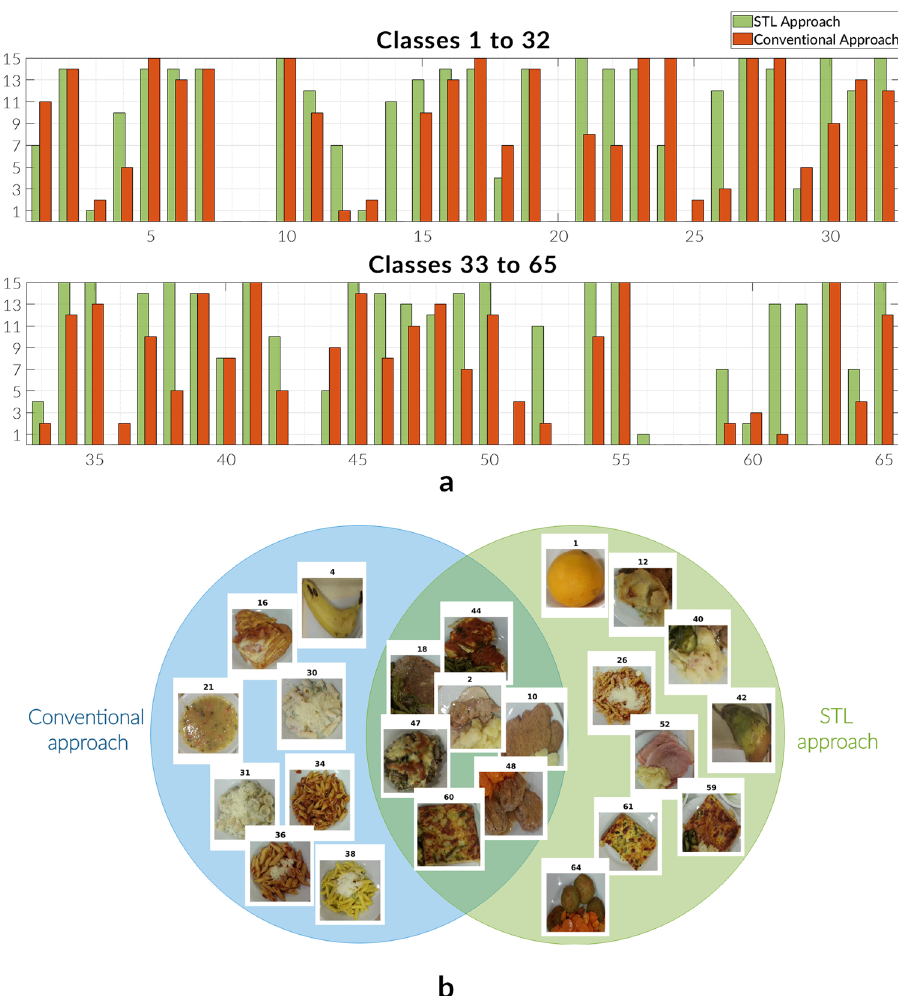
Figure 6. Prediction quality comparison charts in the U-Net scenario. Presented charts display a detailed comparison of both, the conventionally trained network model version and the one using STL in terms of prediction quality of dataset categories. Particular focus in 6b is put on visually highly correlated classes. ( a ) Bar chart Depicts the number of patches per class with prediction quality greater than 75% for all existing categories in an extended version of the UNIMIB2016 test dataset bringing the minimum amount of patches per class from 2 to 15. In 47.7% of classes the STL approach counts more definite predictions than the Conventional method. ( b ) Venn diagram Shows cases of classes in which both network model versions have difficulties in terms of classification definiteness in the UNIMIB2016 test